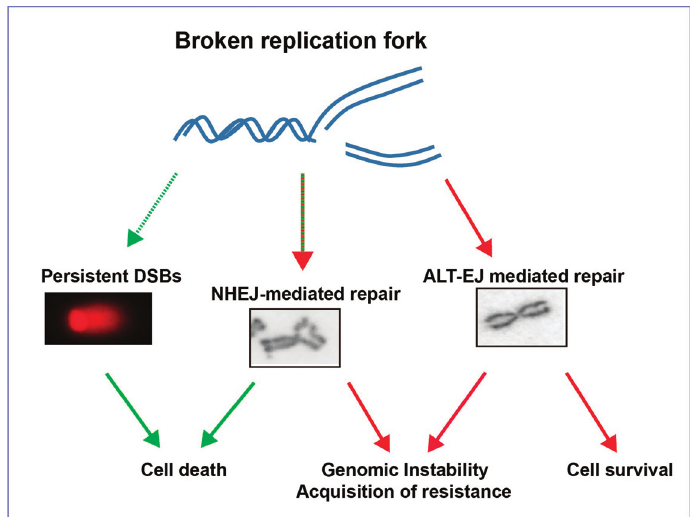
Figure5 -ModeldepictingtheimplicationsoflowDSBaccumulationafterPARPiinBRCA-deficientcells.InBRCA-deficientcells,Olaparibtreatment causes replication fork collapse. In rare samples, DSBs may accumulate and such a persistent load of DSBs may trigger cell death (left outcome). How- ever, in most samples, DSBs are processed by error-prone pathways, such as non-homologous end joining (NHEJ) and alternative end joining (ALT-EJ). Error-prone pathways such as ALT-EJ, may not induce aberrant re-arrangement of chromosomes and may promote cell survival (middle outcome - see